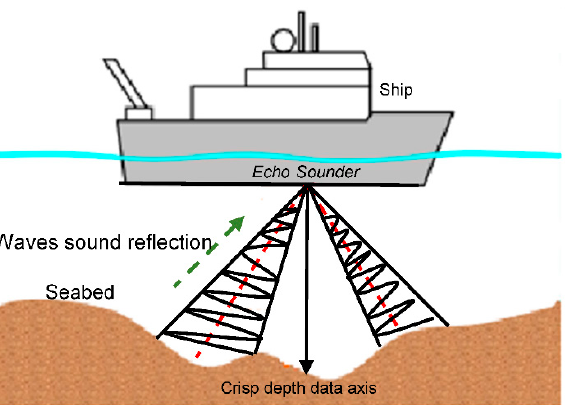
Figure 11. Illustration of procedure in taking depth data point (in meter) of the seabed, which consists of uncertainty complex data.